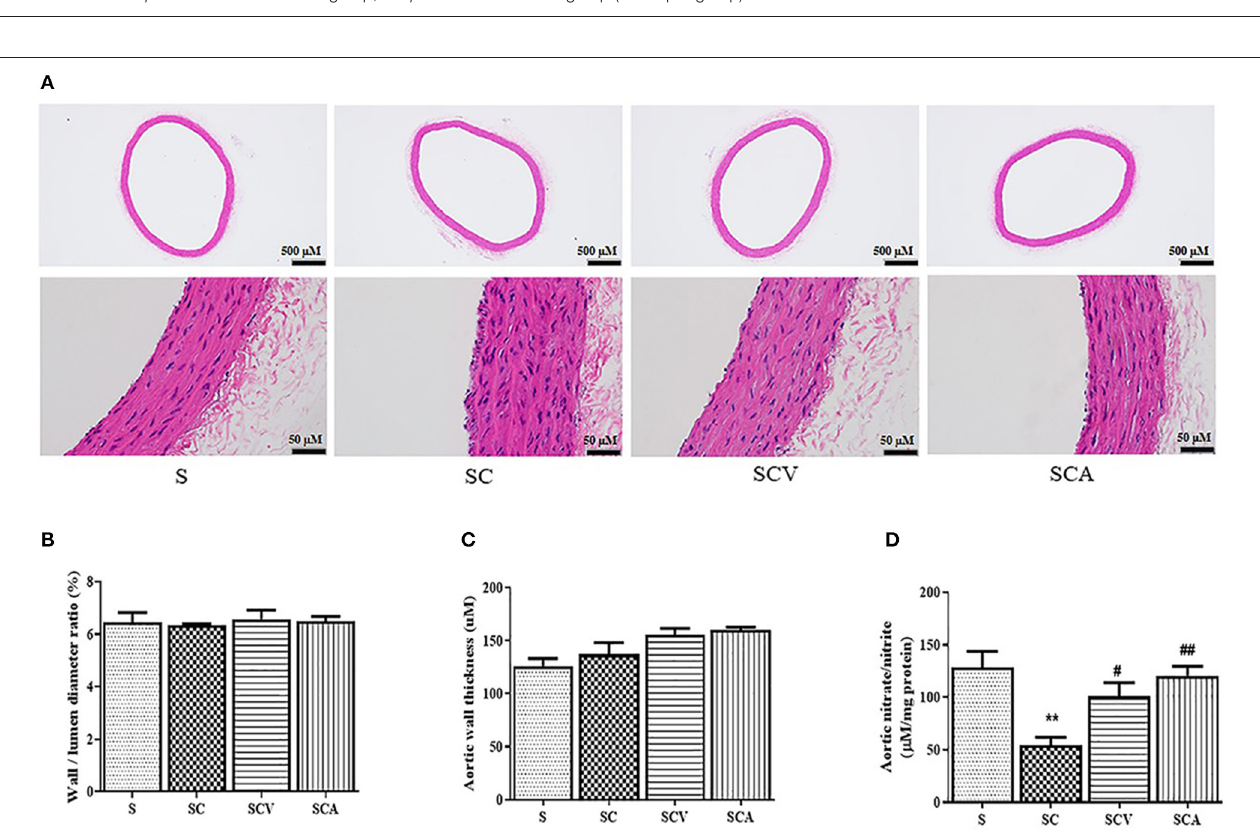
FIGURE 7 | Effect of coconut vinegar supplementation on aortic histopathological changes and nitric oxide bioavailability. (A) Aortic H&E staining; (B) Aortic wall to lumen diameter ratio; (C) Aortic wall thickness; (D) Aortic nitrate/nitrite. Each bar presented in mean ± SEM. ** p < 0.01 vs. the control group; # p < 0.05; ## p < 0.01 vs. the SC group ( n = 6 per